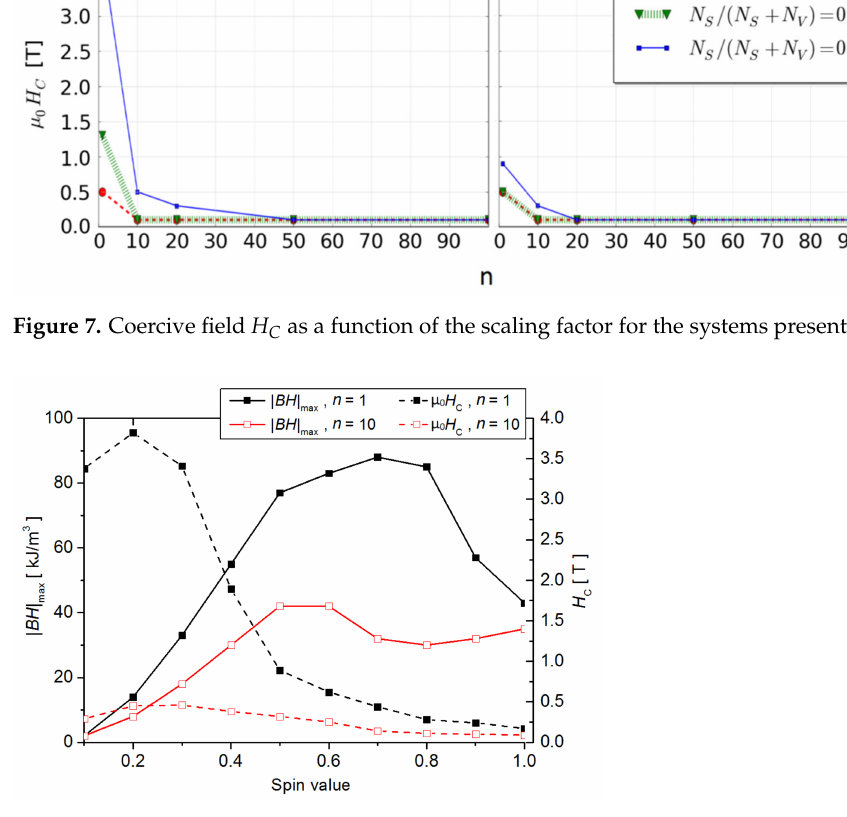
Figure 8. Dependencies of the S value on the coercive field and the estimated energy product for the systems with K S = 5 × 10 − 4 eV, K V = 0 eV, N S /( N S + N V ) = 0.7 and n = 1 as well as n =